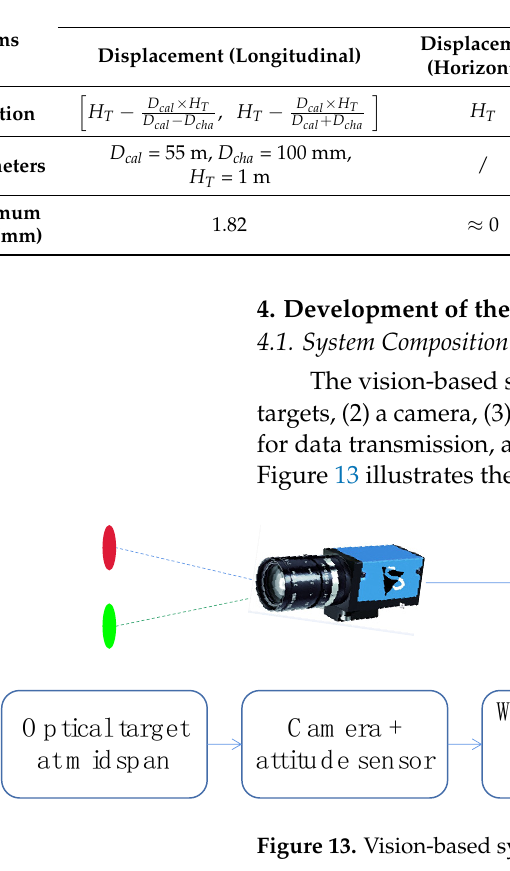
Table 3. Summary of measurement errors caused by wind-induced camera shaking. Type of Camera Motion Figure 12. Optical targets appearing at different positions in the monitoring range due to camera shakings.